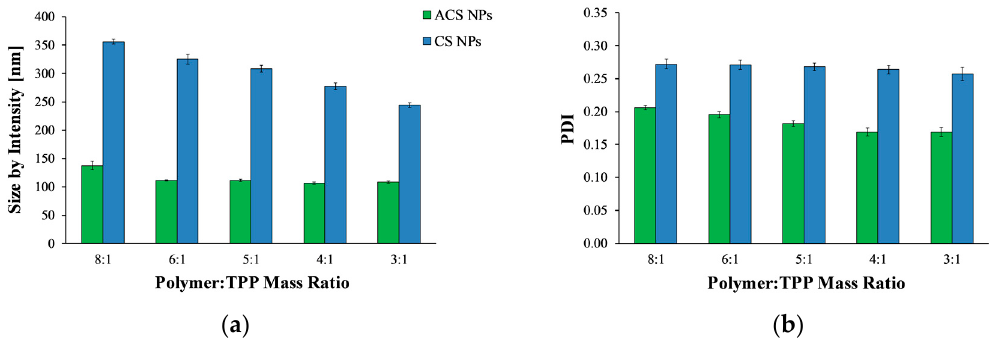
Figure 1. ( a ) Mean hydrodynamic diameter and ( b ) polydispersity index (PDI) value of acrylated chitosan (ACS) (green) and chitosan (CS) (blue) nanoparticles prepared at different polymer to crosslinker mass ratios.